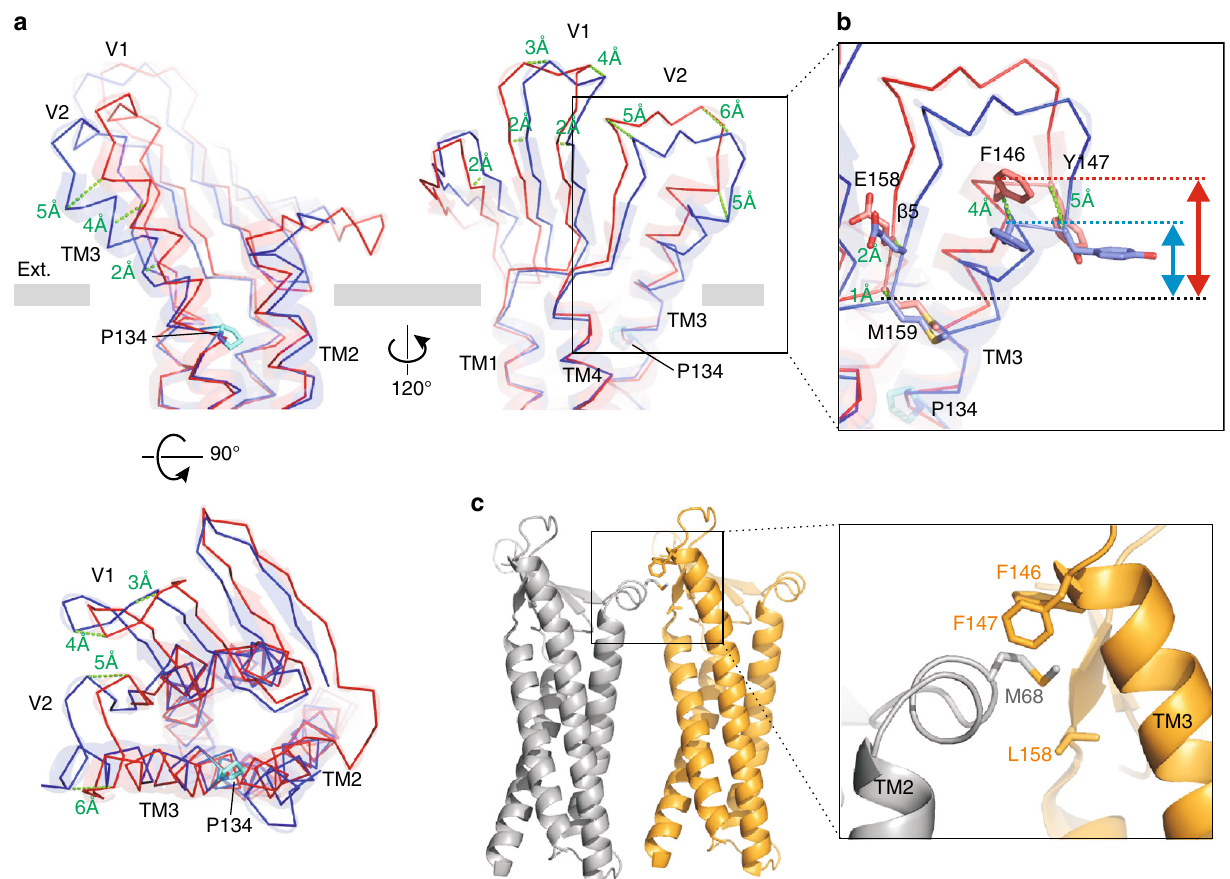
Fig. 4 Structural shift by TM3 bending. a Superposition of mCldn3 cryst and mCldn3 cryst P134A. The C α strands of mCldn3 cryst and mCldn3 cryst P134A are colored blue and red, respectively. Distances arising from the TM3 bending are shown in green. b Enlarged view of the cis-interaction pocket periphery. The residues constituting a cis-interaction pocket are shown in stick representation. Double-headed arrows indicate the size of the cis-interaction pocket in the direction perpendicular to the cell membrane plane. c Cis-interaction observed in mCldn15 crystal (PDB ID: 4p79). Two neighboring molecules of mCldn15 are shown in ribbon representation, and key residues in the cis-interaction are shown in stick